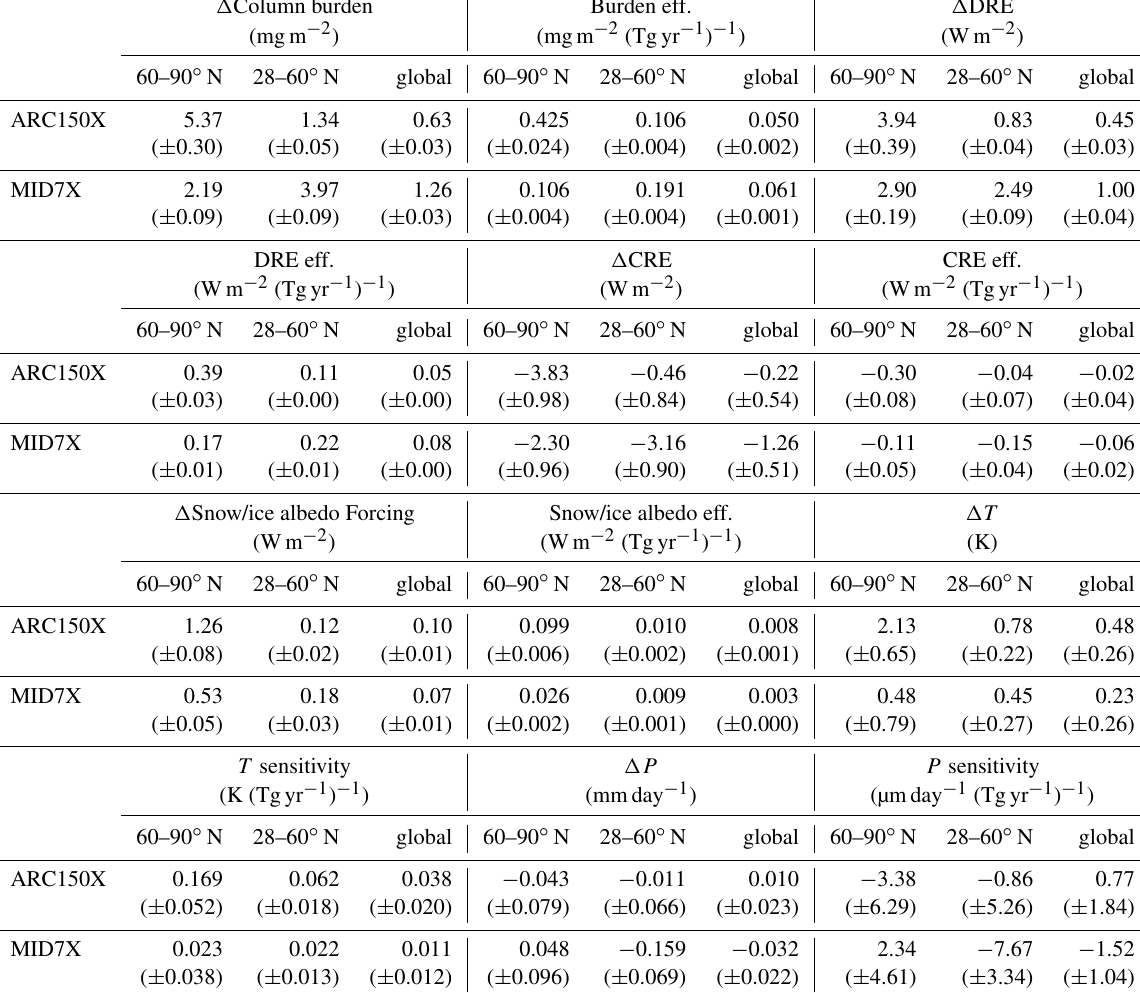
Table 1. Changes in black carbon (BC) column burden, direct radiative effect (DRE), and cloud radiative effect (CRE) at the top of the atmosphere (TOA), surface BC snow/ice albedo forcing, surface temperature ( T ), and total precipitation rate ( P , including rain and snow) averaged over the Arctic (60–90 ◦ N), midlatitudes (28–60 ◦ N), and the globe between perturbed (ARC150X/MID7X) and PD simulations. BC burden, DRE, CRE, and snow/ice albedo forcing efficiencies, T sensitivity and P sensitivity are calculated as changes in regional mean BC column burden, DRE, CRE, snow/ice albedo forcing, T and P divided by changes in global total BC emissions between perturbed and PD simulations. 1 σ for 80 annual means is shown in the parentheses. Note that these quantities include the impact of slow responses and feedbacks (e.g., changes in sea surface temperature and sea ice and feedbacks with clouds) so are not strictly comparable to the conventional definition of radiative